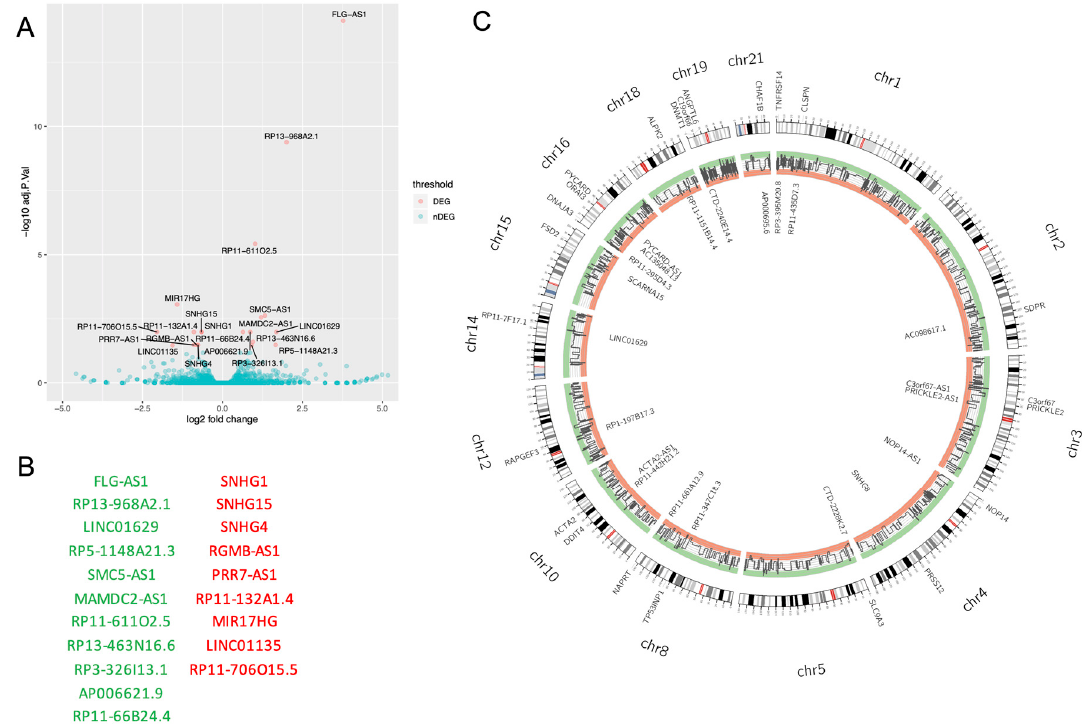
Figure 1. Olaparib modulated the expression of 20 long non-coding RNAs (lncRNAs). ( A ) volcano plot displaying lncRNAs whose expression is changed by olaparib treatment. Shown in red are 20 lncRNAs whose expression changes significantly (FDR < 0.05). ( B ) lncRNAs whose expression changes significantly after olaparib treatment, ranked from highest to lowest logFC. logFC > 0 are shown in green; logFC < 0 are shown in red. ( C ) lncRNAs which might regulate gene expression in cis following olaparib treatment. The inner side of the Circos shows lncRNA, while the outer side shows genes whose expression might be cis -regulated by each lncRNA. The Circos shows a total of 24 pairs each made up of one olaparib-modulated lncRNA ( p -value < 0.05) and one olaparib-modulated gene ( p -value < 0.05) whose relationship is statistically significant ( p -value <